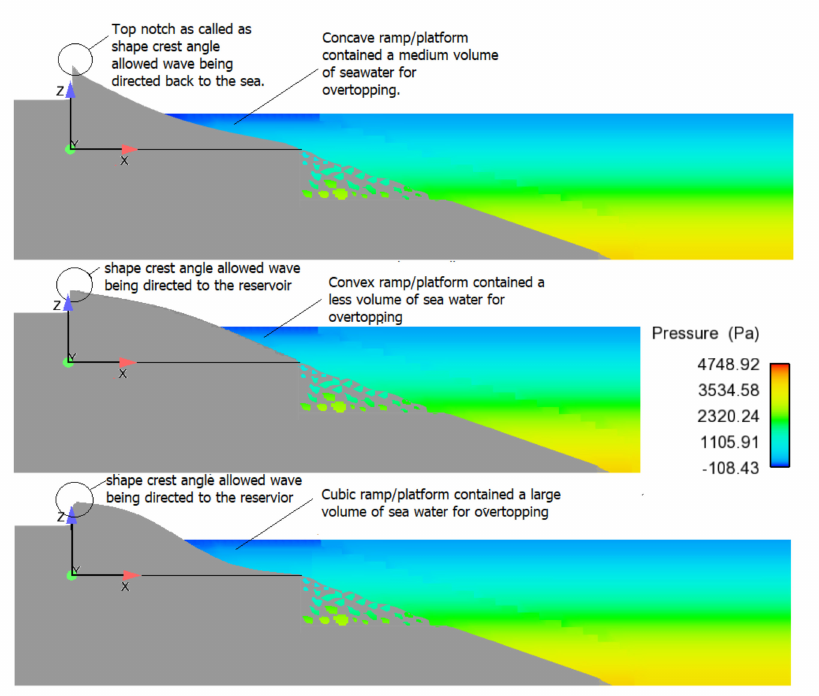
Figure 17. Image showing that ramp shapes (concave, convex, cubic (-)) and angle at the crest will influence the overtopping discharge on OBREC